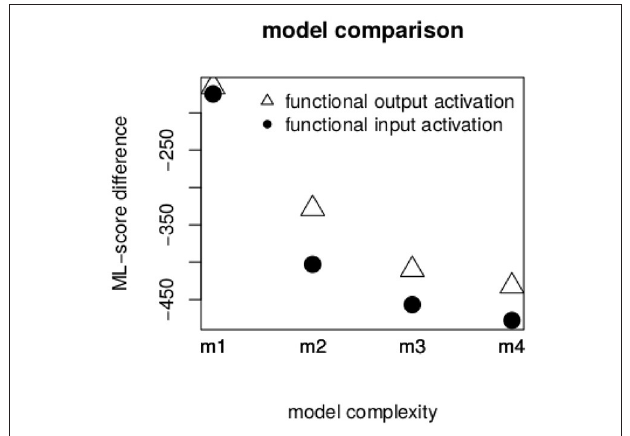
FIGURE 2 | ML-score difference between model m0 and models m1 to m4. The larger the difference, the better the model’s goodness of fit.